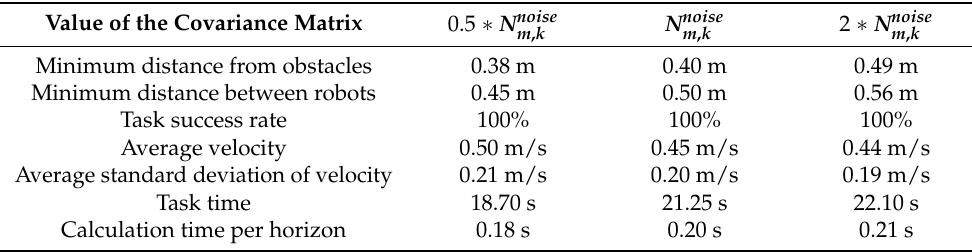
Table 2. Comparison under different level disturbances